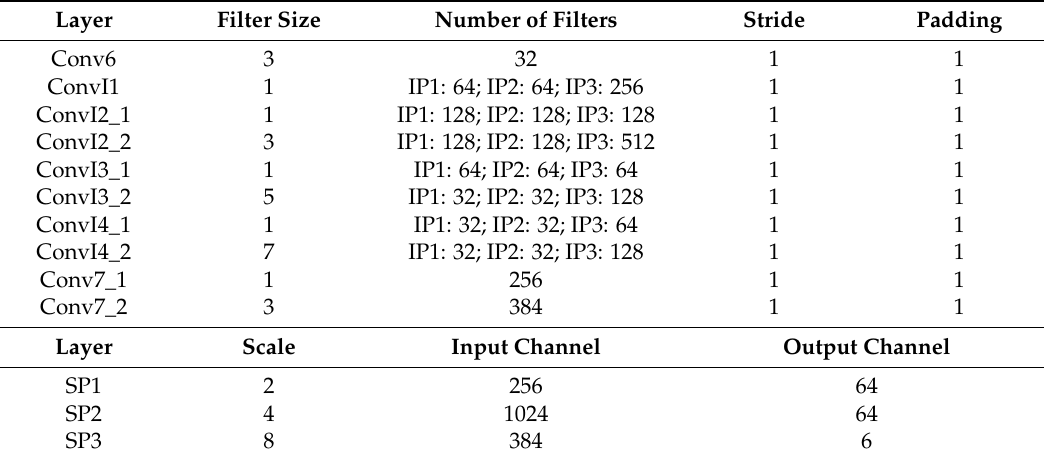
Table 2. Configurations of layers in decoder.